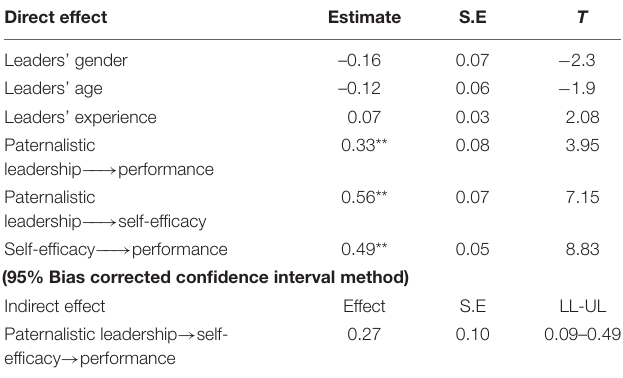
TABLE 3 | Direct and indirect